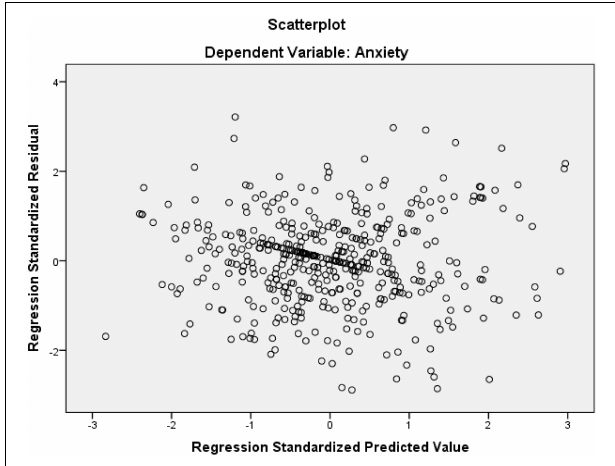
FIGURE 5 | Scatter plot of residuals.